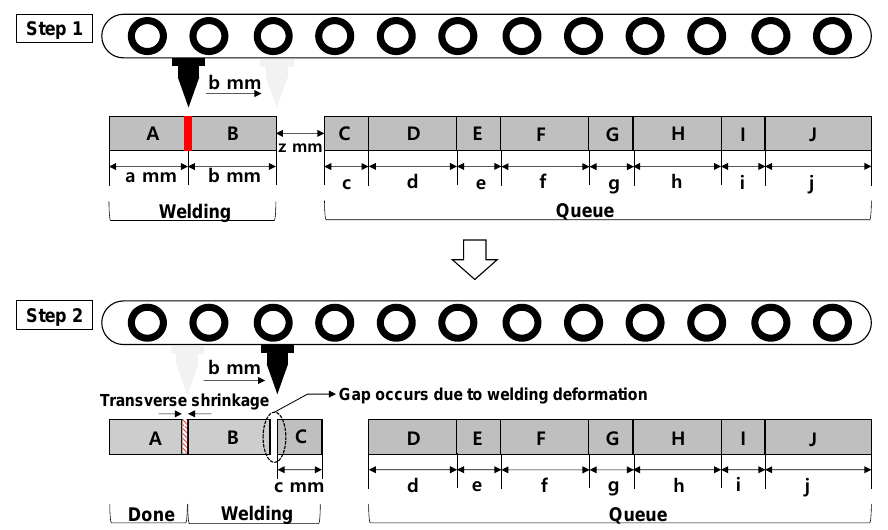
Figure 3. An example of a problem that can occur during the FSW automation process due to welding deformation.